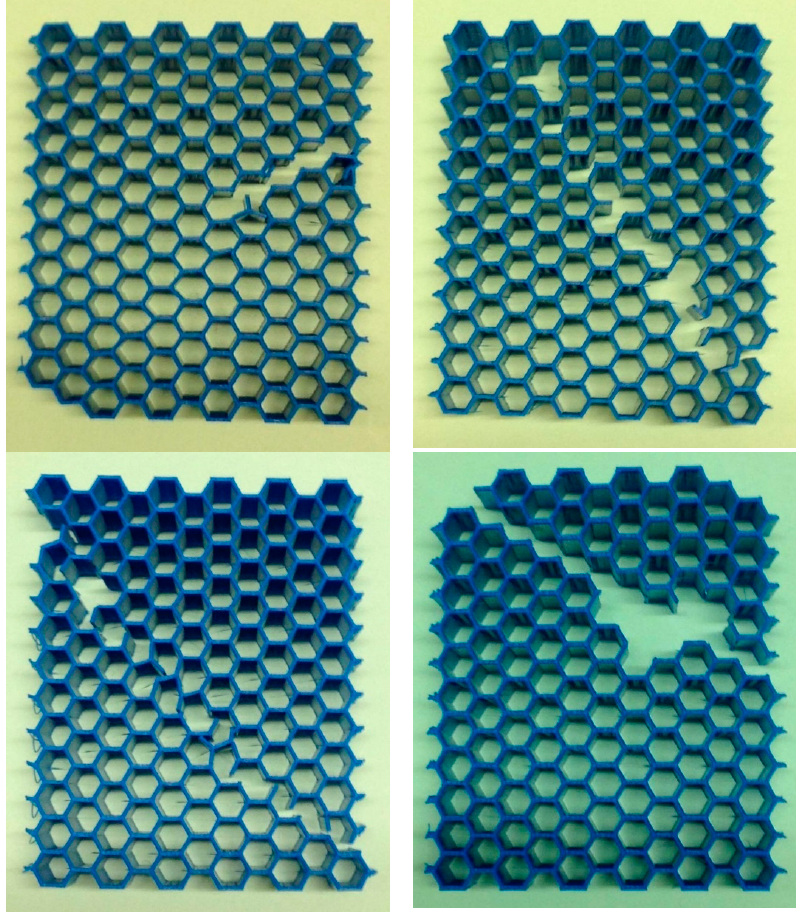
Figure 9. The 45° failure pattern in the honeycombs. Figure 9. The 45 ˝ failure pattern in the